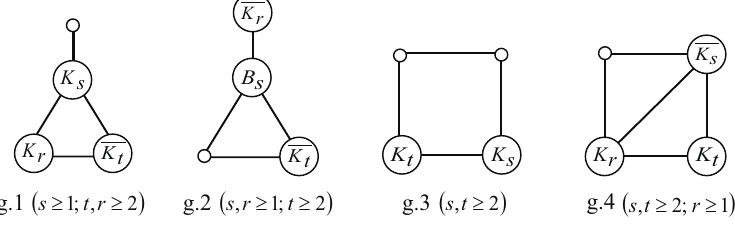
Figure 2. All graphs of d ( G ) = 2, n ( G T ) = 4 and dim ( G ) = n ( G ) −